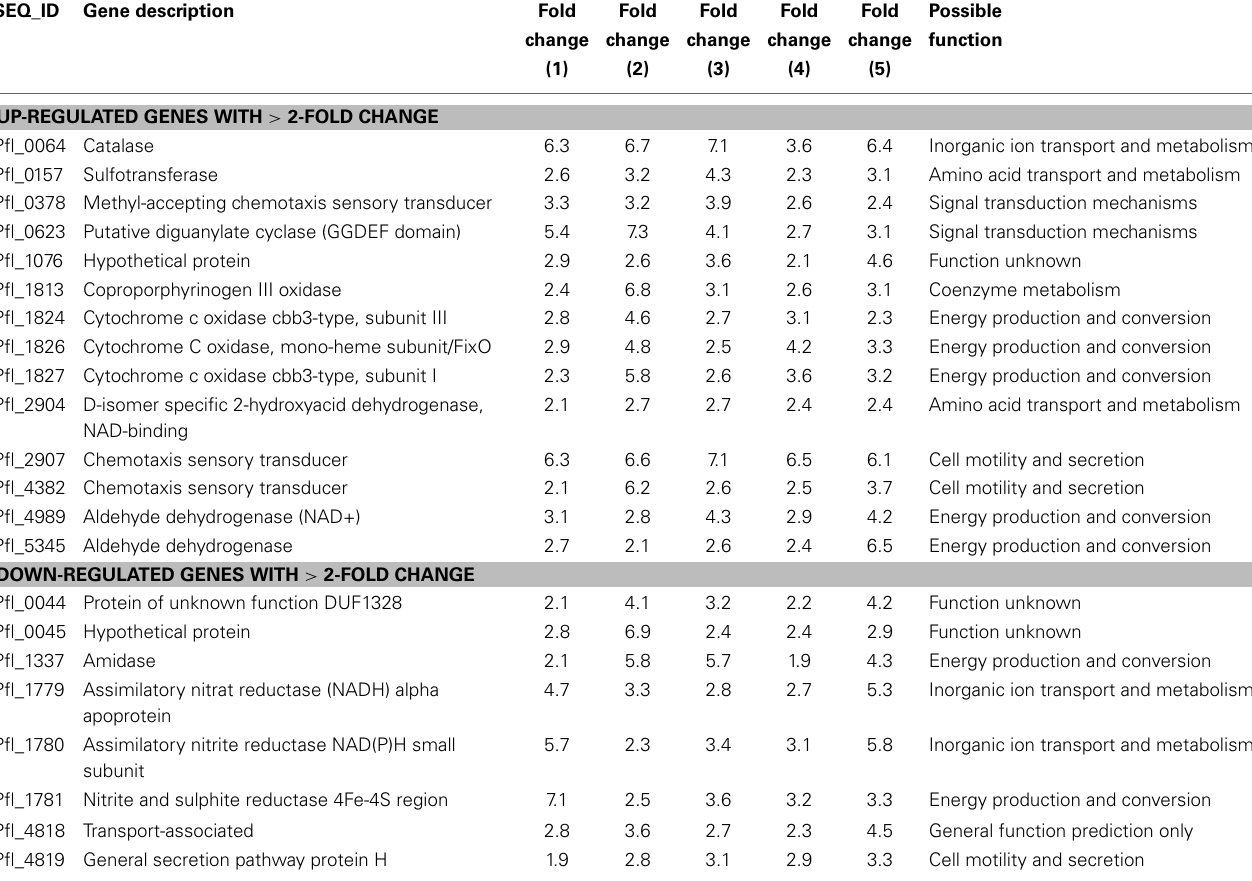
Table 2 | Common genes differentially expressed in P. fluorescens Pf0–1 exposed to volatiles produced by four bacterial species and a mixture of these species in sand containing artificial root